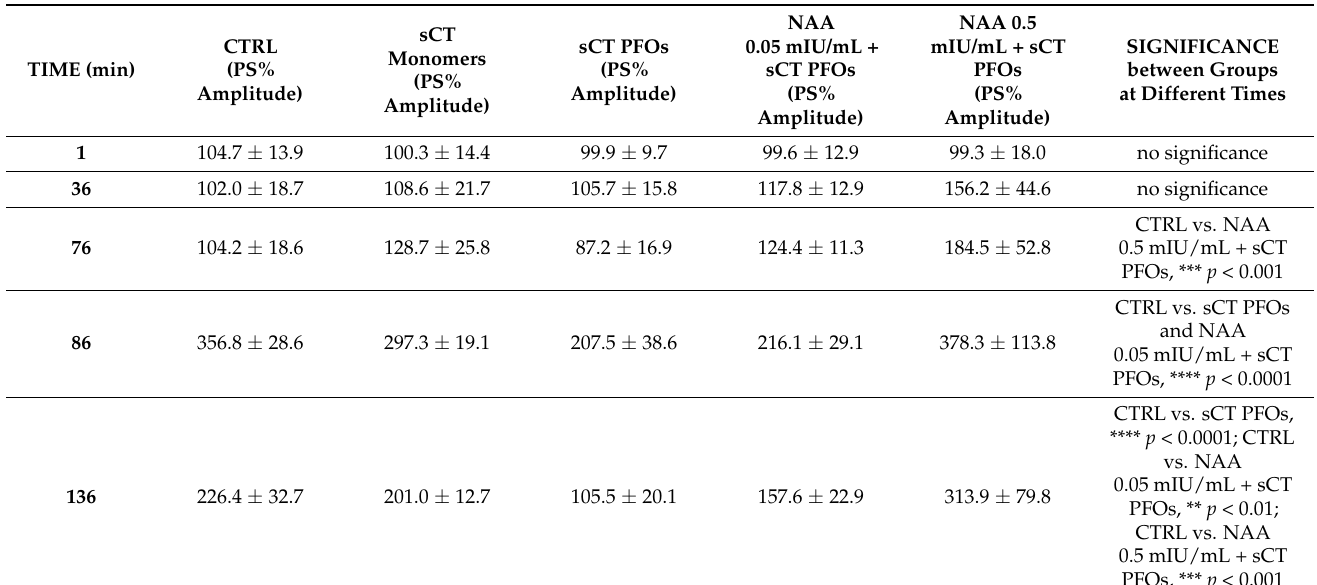
Table 3. Percentage of PS amplitude values of BST and LTP recorded in the CA1 region of hippocampal slices from the control group and groups treated with NAA and sCT at different